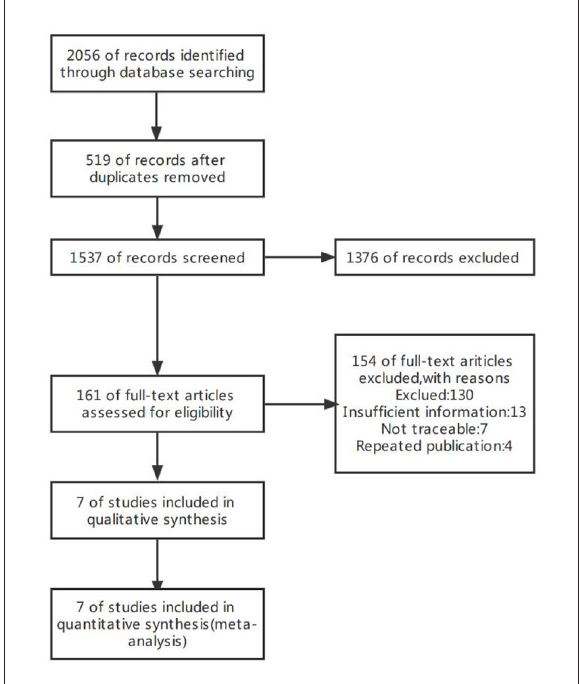
FIGURE1 Flow diagram of literature search and exclusion